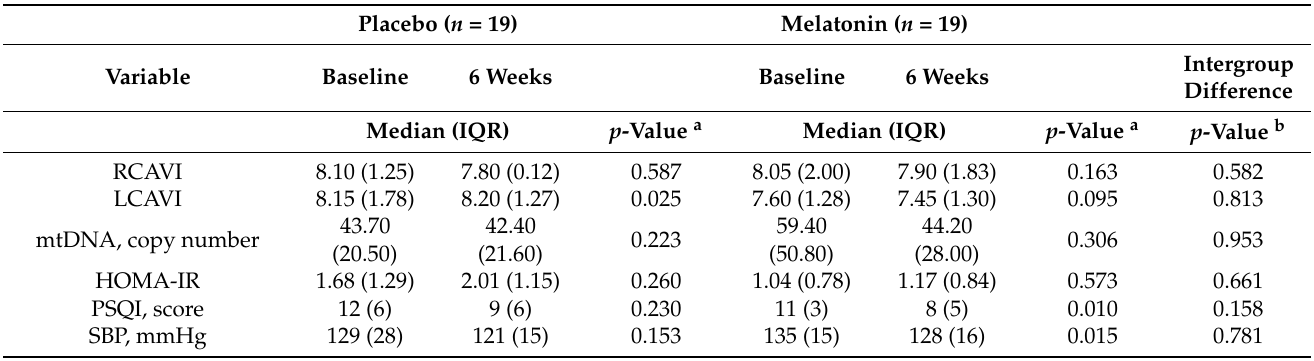
Table 2. Changes in cardiovascular parameters, sleep index, insulin resistance, and mitochondrial